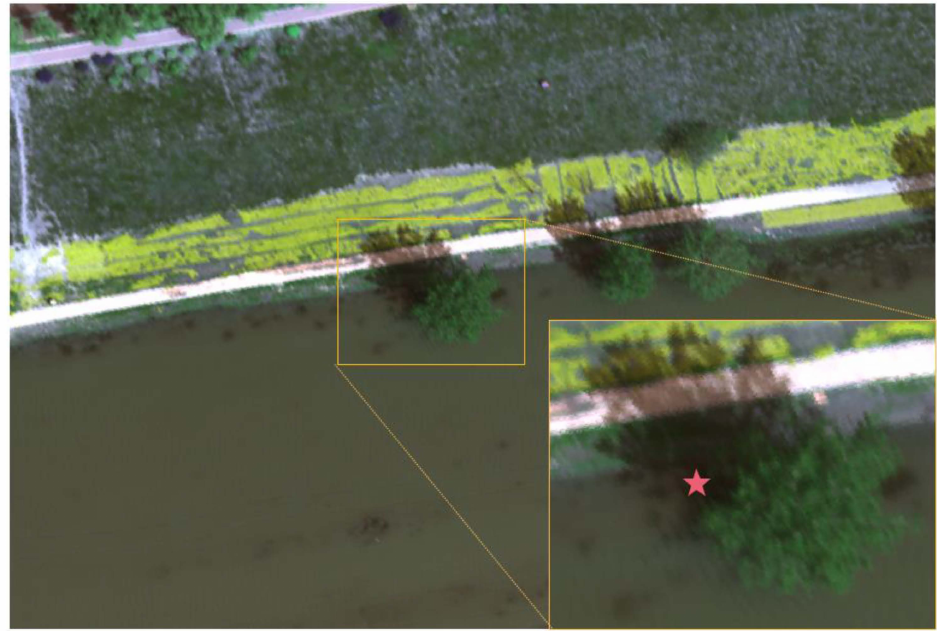
Figure 6. The invalid sampling points because of shadow of